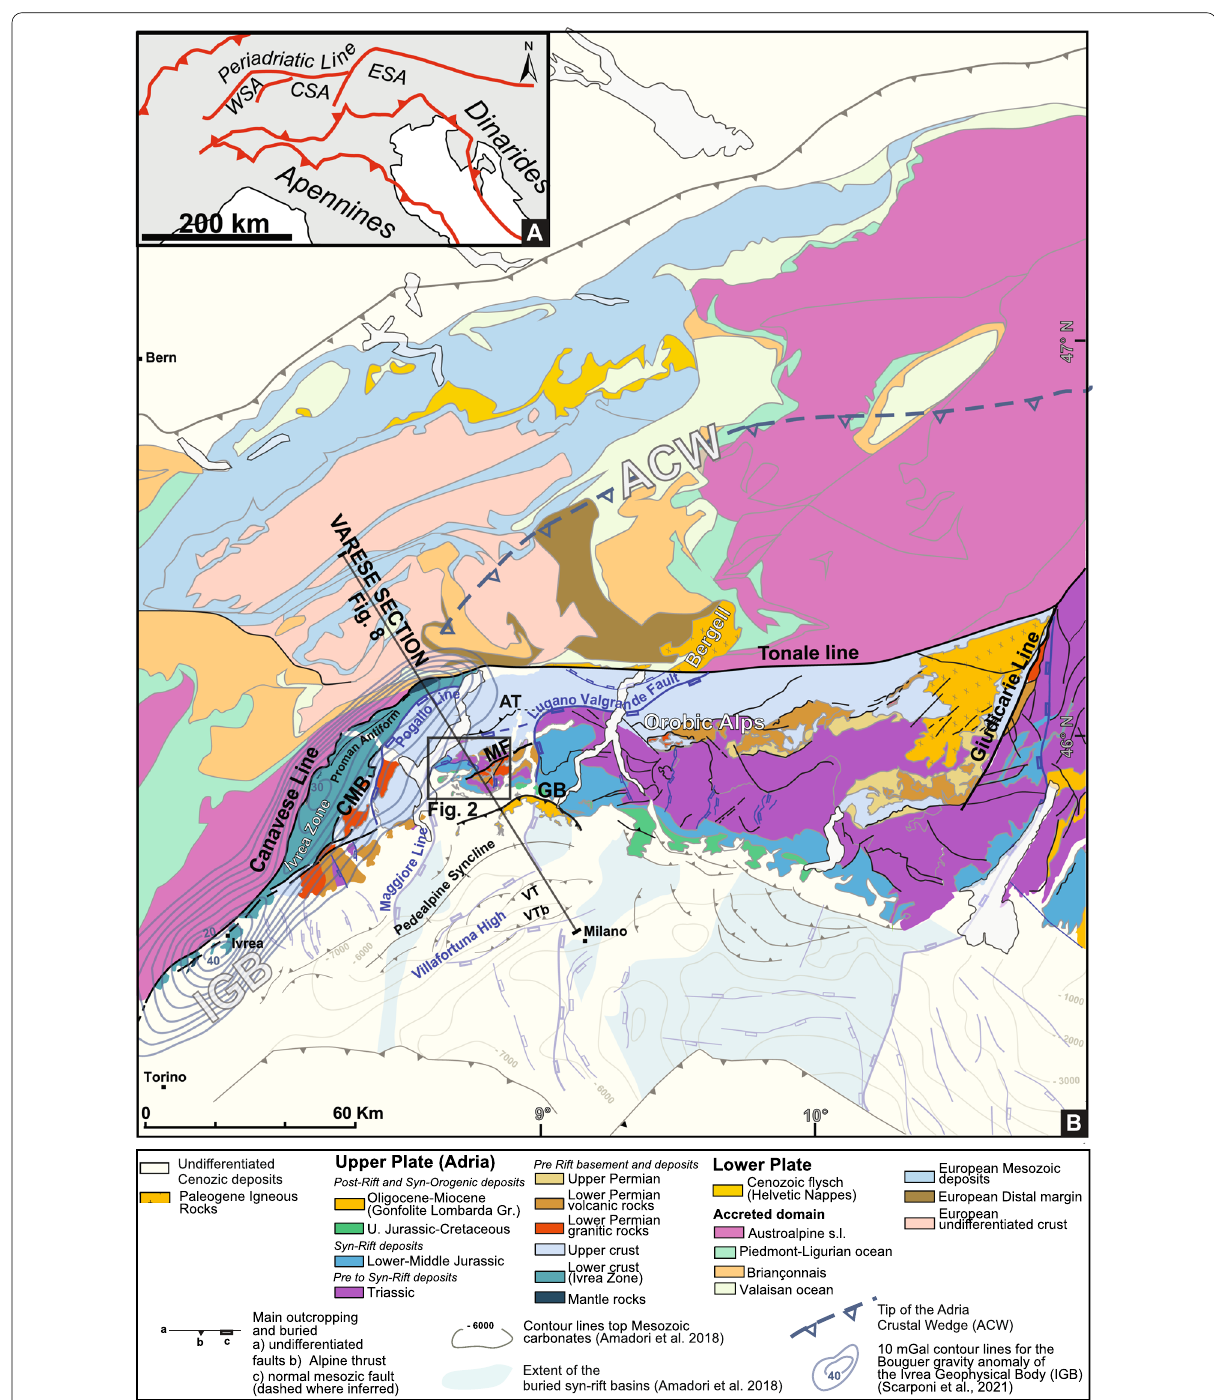
Fig. 1 a Tectonic scheme of the Alps (Codes: CSA, Central Southern Alps; ESA, Eastern Southern Alps; WSA, Western Southern Alps); b simplified geological map of the Central and Western Southern Alps with emphasis on the Alpine and rift-related structures (i.e., Maggiore Line, Pogallo Line and Lugano Valgrande Fault, in blue); the extent of the Ivrea Geophysical Body (IGB), the surface projection of the Adria Crustal Wedge tip (ACW) and the extent of the Varese Ara (black box) are also indicated; Fault Codes: AT: Arosio thrust; CMB: Cossato–Mergozzo Line; GB: Gonfolite backthrust; IGB:Ivrea Geophysical Body; MF: Marzio Fault; VT and VTb: Villafortuna-Trecate thrust and backthrust, respectively (sources for the maps: Amadori et al., 2019; Fantoni et al., 2002, 2004; Mazzucchelli et al., 2014; Rosenberg & Kissling, 2013; Scardia et al., 2015; Scarponi et al., 2021; Schmid et al., 2017; Zanchi et al., 2019 and this study for the Varese